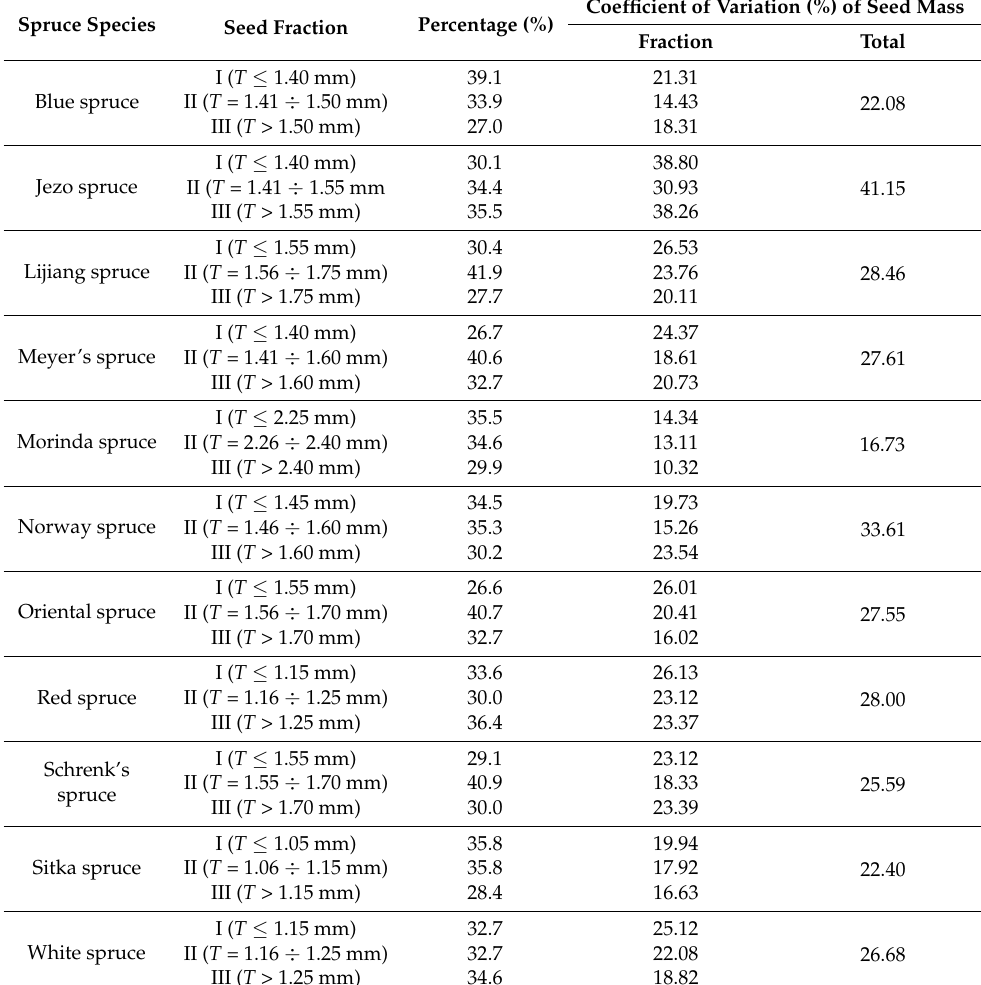
Table 4. Coefficient of variation of seed mass in three fractions of spruce